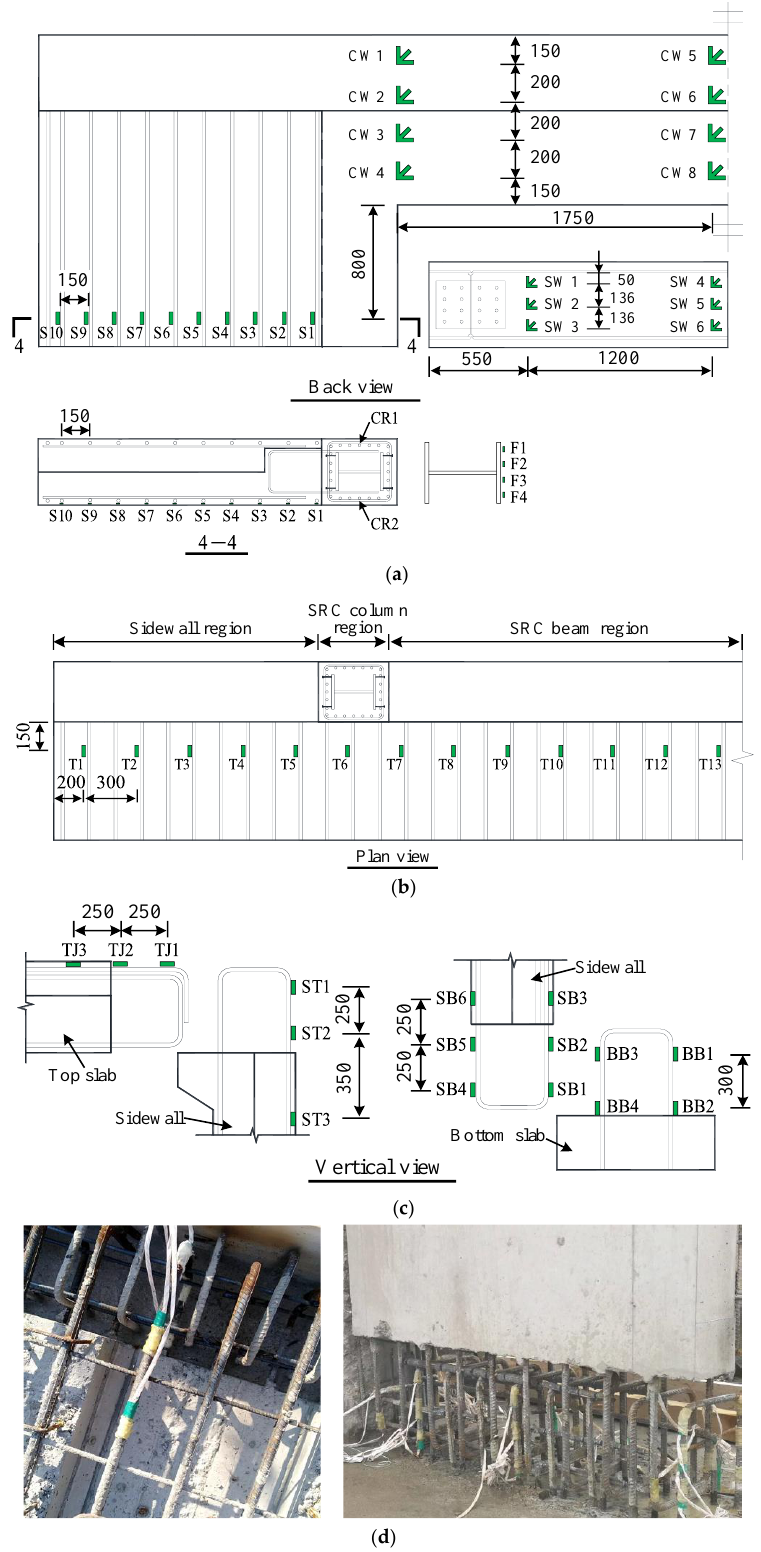
Figure 7. Arrangement of strain gauges (units: mm): ( a ) strain-gauge layout in sidewall and entrance frame, ( b ) strain-gauge layout in the top slab, ( c ) strain-gauge layout in the U-type rebar overlapping connections, and ( d ) photograph of strain gauge arrangement at U-type rebar overlapping connections.